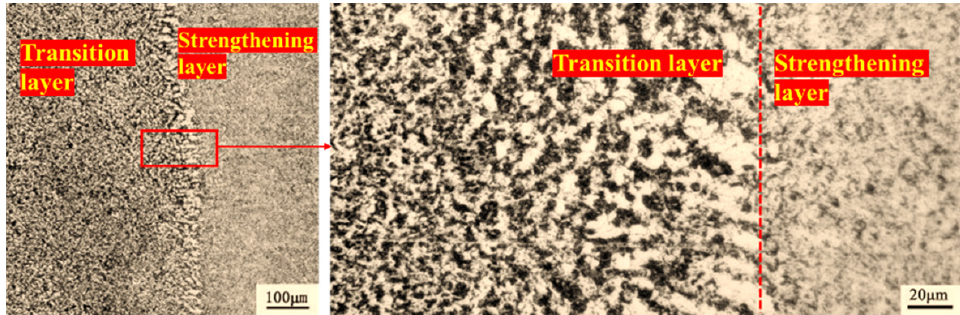
Figure 15. Microstructure of fusion zone between transition layer and strengthening layer.